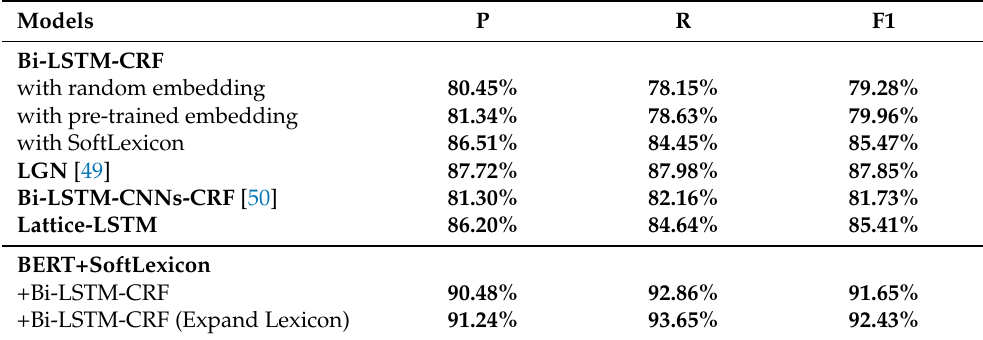
Table 7. Experimental results of eight different models on the power grid dataset. The upper part is the model without using BERT, and the lower part is the model using BERT. The result of all models is from our